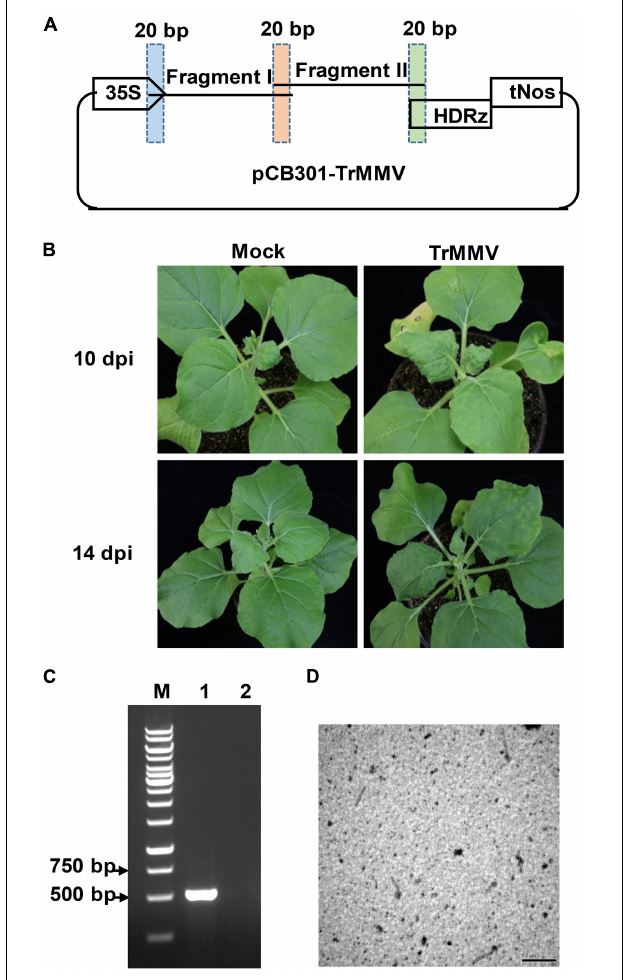
FIGURE 3 | Infectivity of TrMMV on Nicotiana benthamiana . (A) Schematic diagram illustrating the one-step assembly cloning strategy used for the construction of the infectious full-length cDNA clone of TrMMV. Two overlapping TrMMV fragments, I and II, were amplified by polymerase chain reaction and infused to the linearized pCB301 vector. 35S, the cauliflower mosaic virus promoter; HDRz, hepatitis delta virus ribozyme; tNos, Nos terminator. (B) Leaf curling and chlorosis symptoms of N. benthamiana infected by the TrMMV infectious clone at 14 days post infiltration (dpi) and 17 dpi, respectively. (C) RT-PCR analysis of TrMMV RNA accumulation in systemic leaves of inoculated N. benthamiana using TrMMV-specific primers. Lane M, GeneRuler 1kb DNA ladders (Thermo); lane 1, N. benthamiana plants agroinoculated with pCB301-TrMMV at 14 dpi; lane 2, mock plants